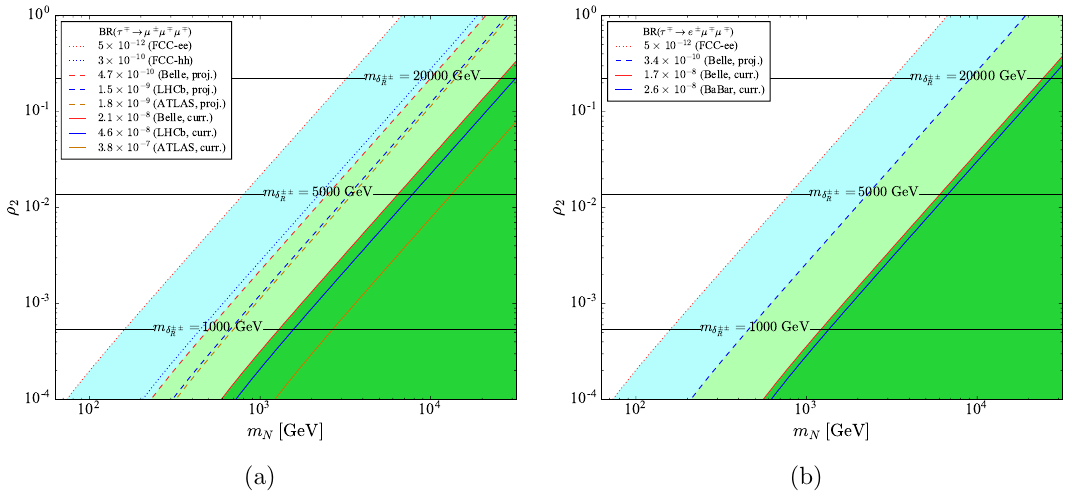
Figure 5. Current and future branching ratio limits in the parameter plane of the right-handed neutrino masses m N and the parameter (cid:26) 2 for the LRSM for the benchmark scenario BP2. (a) Shows the limits from the decay (cid:28) (cid:7) ! (cid:22) (cid:6) (cid:22) (cid:7) (cid:22) (cid:7) , and (b) shows the limits from the decay (cid:28) (cid:7) ! e (cid:6) (cid:22) (cid:7) (cid:22) (cid:7) . The solid black lines represent constant values of the mass of the doubly charged Higgs (cid:14) (cid:6)(cid:6) The amplitude for the LFV process (cid:28) (cid:7) ! e (cid:6) (cid:22) (cid:7) (cid:22) (cid:7) can be obtained by replacing the (cid:28)(cid:22) element in eq. (3.23) with the (cid:28)e element. A limit on the branching ratio of the (cid:13)avour violating decays will constrain the doubly charged Higgs mass from below and the right-handed neutrino mass from above. In (cid:12)gure 4, corresponding to BP1, we show the branching ratio limits for the case where the three right-handed neutrino masses are all equal and denoted by m N , and are varied along with the parameter (cid:26) 2 . In (cid:12)gure 5, we show